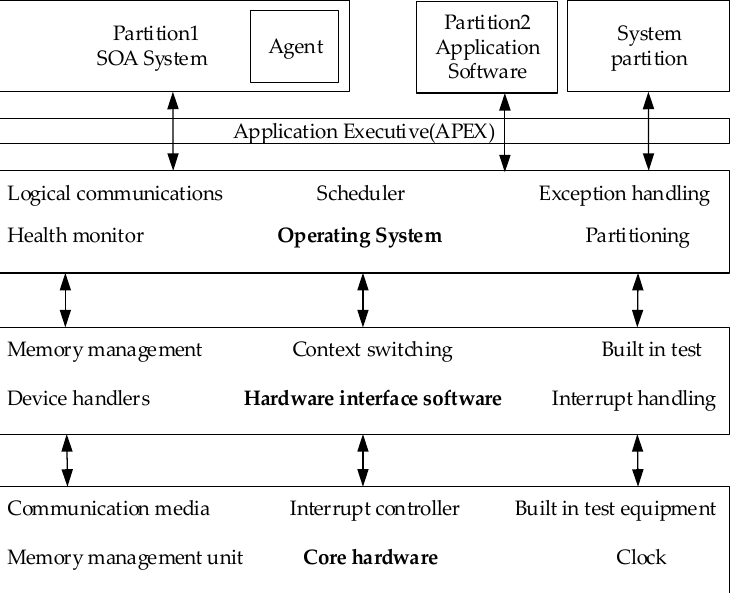
Figure 3. Avionics architecture with agents and